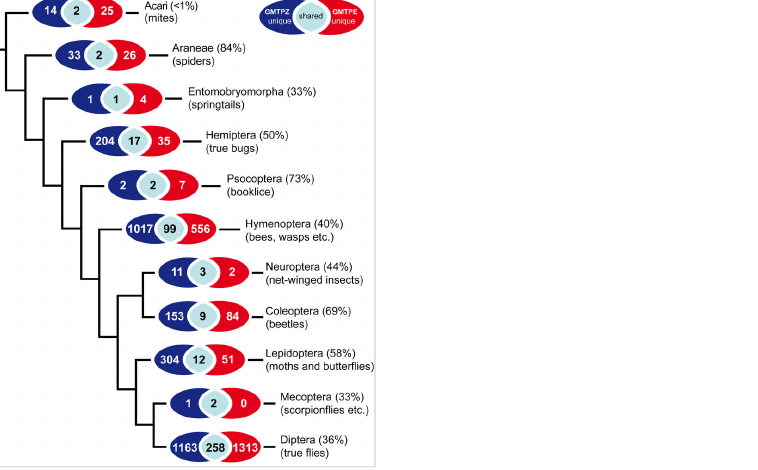
Figure 2. BIN-overlap between the two sample locations on order level; percentage of BINs identi fi ed to genus or species level in parentheses. Tree representing a current estimate of arthropod relationships (from Misof et al. 2014), orders without overlap between the two traps have been omitted.